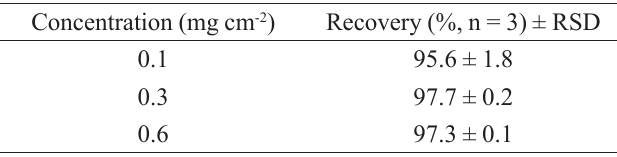
TABLE V - Recovery of nicotine from skin samples (n = 3) Concentration (mg cm -2 )